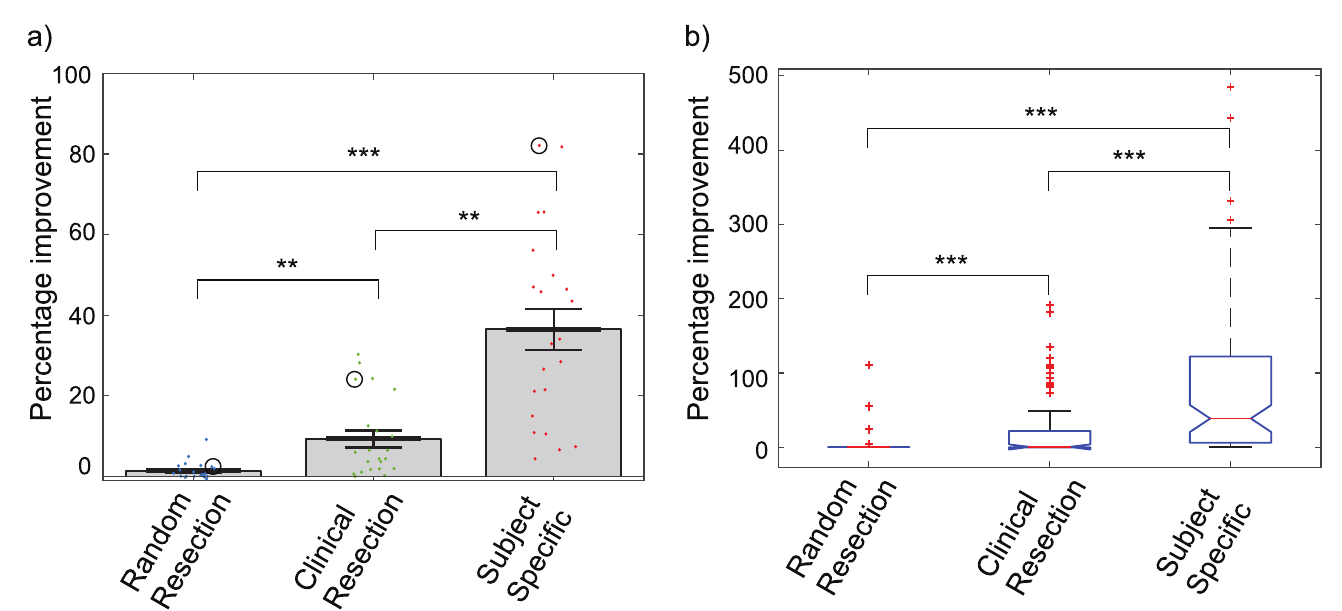
Fig 5. Simulated surgery results comparisons. For every patient three different methods of resection were used and then the escape times were compared for each patient pre and post surgery (surgery simulation results compared to results from simulations where no surgery was carried out). Plot (a) shows the mean percentage improvement in escape time for each patient by resection method, where escape time was taken to be the time by which 3 nodes had hit a seizure state. Grey bars reach the mean of each subject group, error bars show the standard error of the mean. The circled values are the means for the patient shown in plot (b). A single patient representative example is shown in plot (b) , with the percentage improvements found for each simulation plotted and compared by resection technique. Stars represent the significance level, 1 star for significance at p < 0.05, 2 stars for p < 0.01 and 3 stars for p < 0.001. A Mann-Whitney U test with Bonferroni correction was carried out to find the p-values following significant results found from Kruskal- Wallis tests.